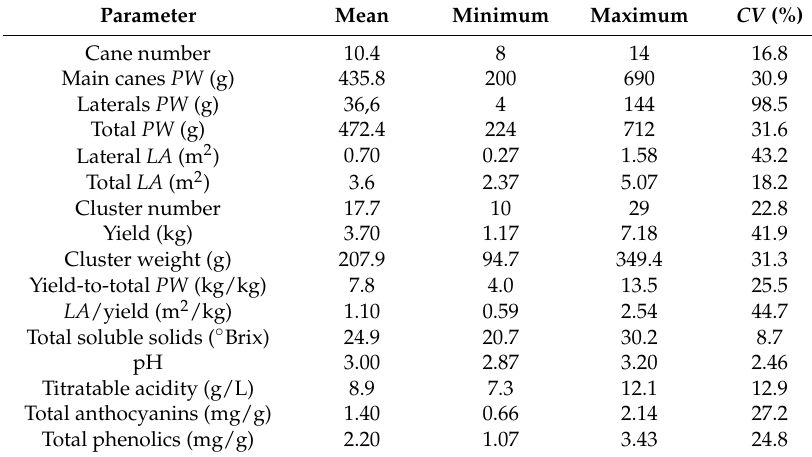
Table 1. Main vegetative, productive and grape compositional features of the test vineyard. For each parameter, mean, range (min, max) and coefficient of variation ( CV ) calculated as standard deviation to mean ratio are shown. PW = pruning weight; LA = leaf